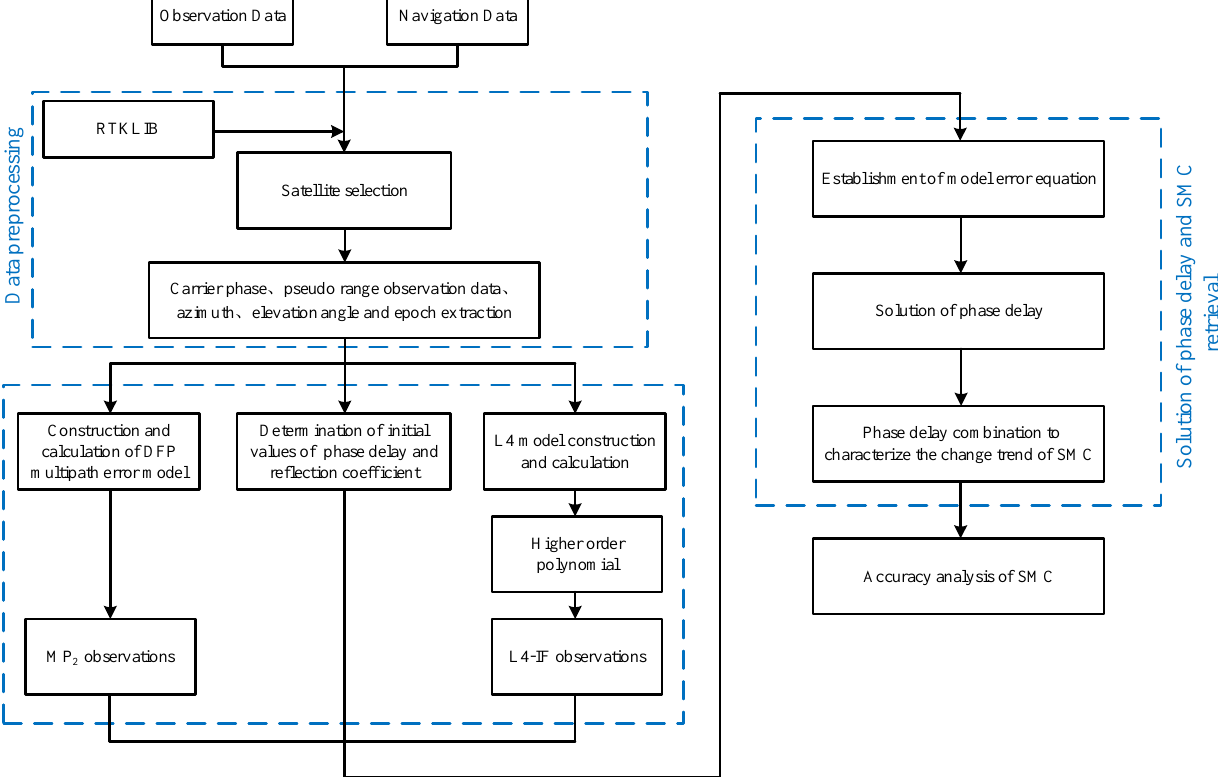
Figure 5. The technical process we followed for multisatellite dual-frequency combined multipath error SMC retrieval. Note: RTKLIB is an open-source program package for standard and precise positioning with GNSS (global navigation satellite system). RTKLIB consists of a portable program library and several APs (application programs) utilizing the library (http://www.rtklib.com/) (accessed on 10 February 2022).